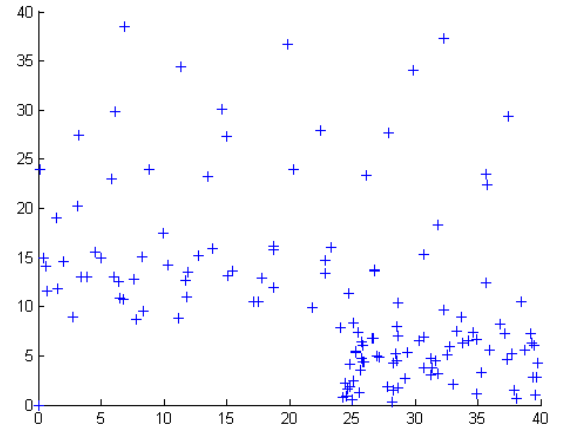
Figure 3 . Clustered layout of targets (150 targets in a 40 × 40